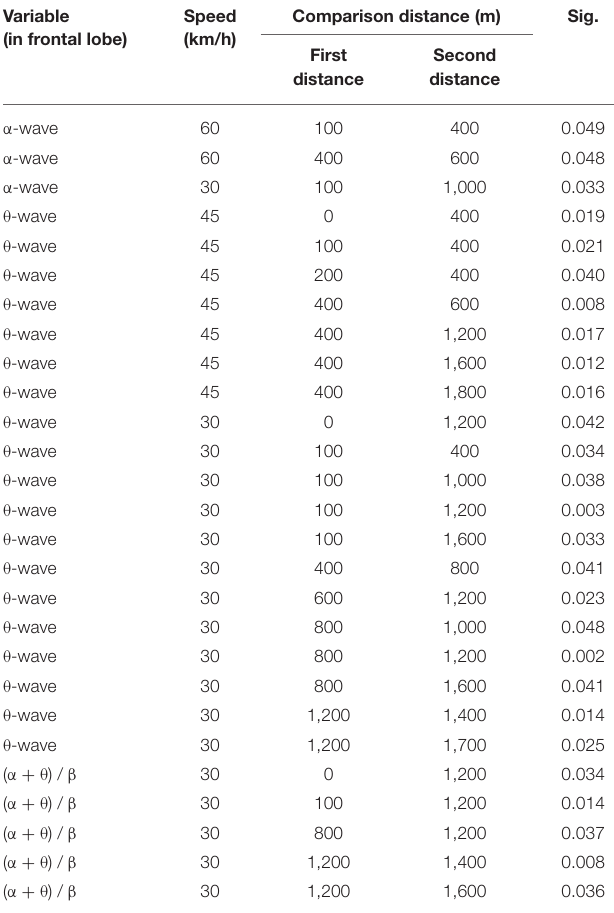
TABLE 5 | Tests of contrasts of different speeds for various driving distances. Variable (in frontal lobe)